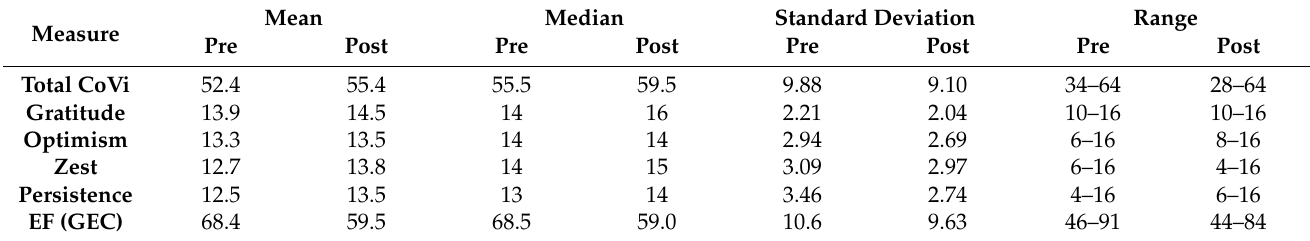
Table 1. Descriptive statistics of covitality and executive functioning measured over